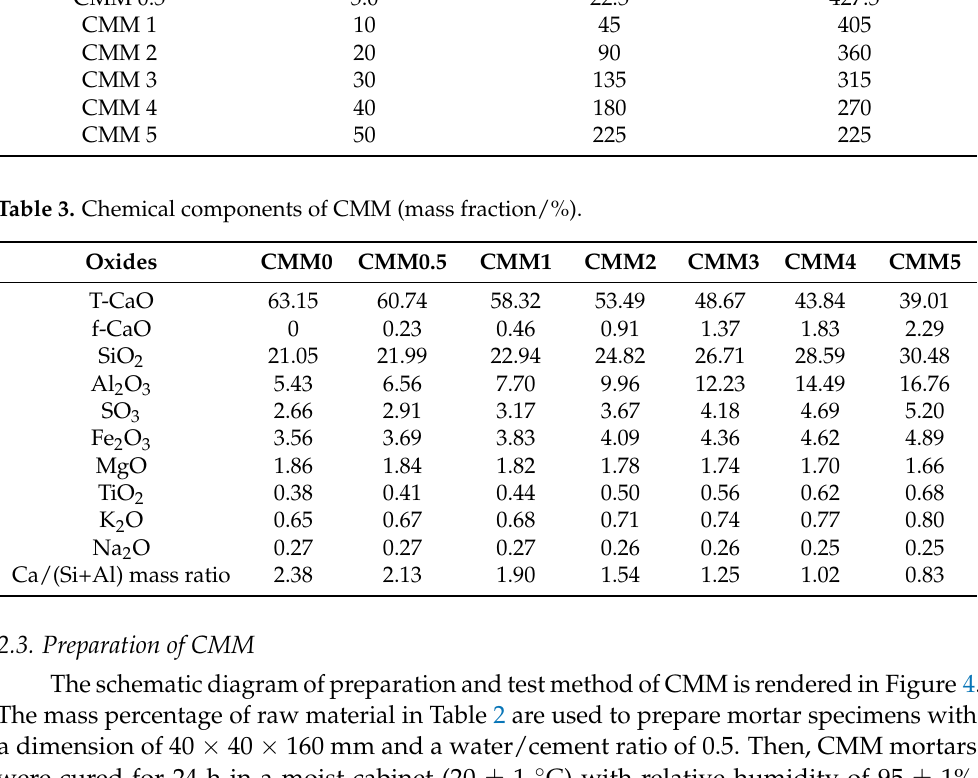
Figure 3. Microscopic morphology of (a) CFB fly ash and (b) OPC 42.5.